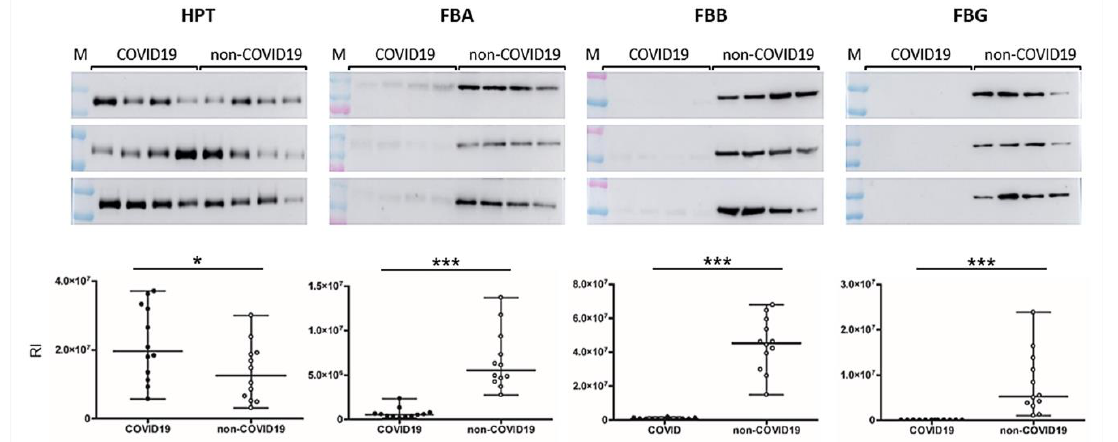
Figure 3. Validation of the differentially expressed proteins found in discovery phase by Western blotting. Box and Whiskers plots represent differentially expressed proteins. COVID-19 patients are situated on the left side and non-COVID-19 patients on the right side of each membrane. Two-tailed Student t -tests were employed to calculate the differences between groups. * and *** showed statistical significance, * p < 0.05, *** p < 0.001. HPT, haptoglobin; FIBA, fibrinogen alpha chain; FIBB, fibrinogen beta chain; FIBG, fibrinogen gamma chain; M: molecular weight marker; RI, relative intensity.